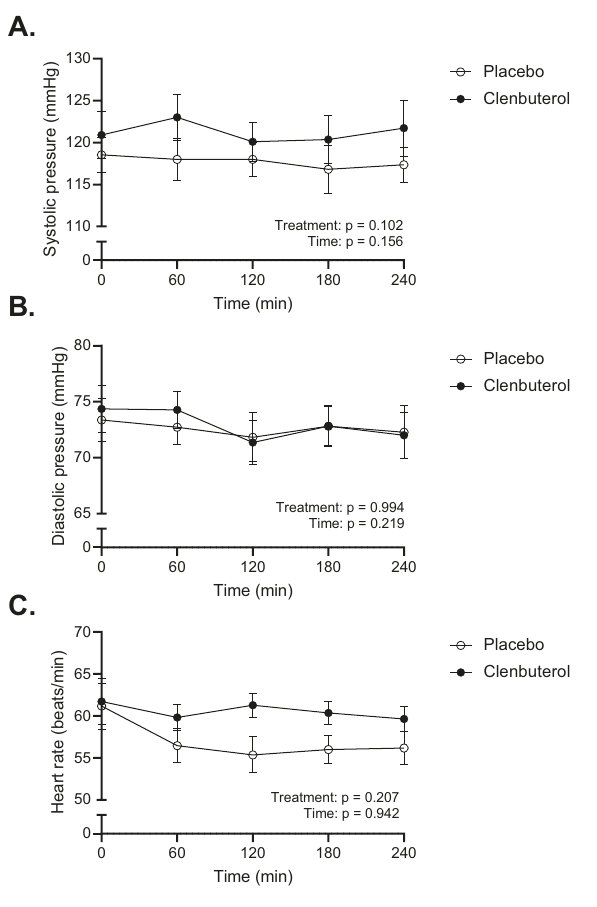
Fig.7 |Acuteclenbuteroltreatment(20 µ g)doesnot affectbloodpressureand heartrate.A Systolicbloodpressure(mmHg). B Diastolicbloodpressure(mmHg). C Heart rate (beats/min). All data were analyzed by means of a linear mixed model analysis without correction for multiple comparisons. Clenbuterol: n =11. Placebo: n =11. Data are presented as mean±SEM. Source data are provided as a Source Data fi